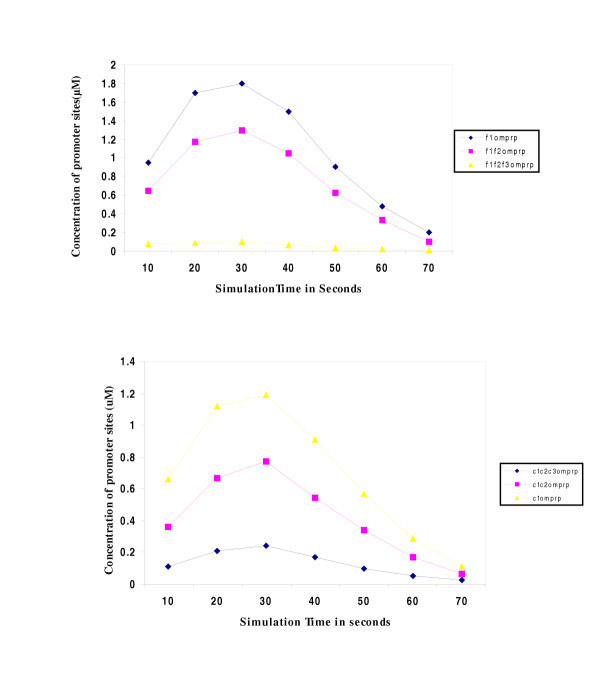
Regulator-promoter complex formation simulation The intermediate products of simulation namely the regulator-promoter complexes for regulation of (a) OmpF: f1omprp – blue; f1f2omprp – pink; f1f2f3omprp – yellow and (b) OmpC: c1omprp-yellow; c1c2omprp-pink; c1c2c3omprp-blue respectively.